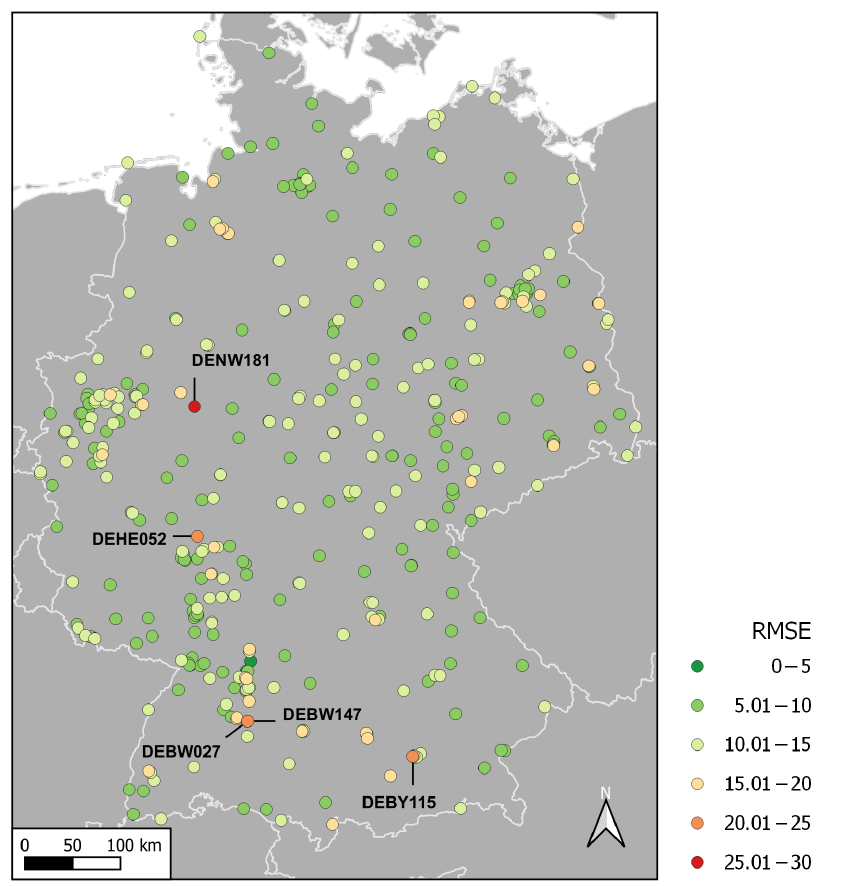
Figure 6. Spatial distribution of the air quality monitoring stations and their RMSE from the loo-cv in µgm − 3 from run 7 with dataset (1). Stations are labelled with their station codes when their RMSEs were above 20µgm − 3